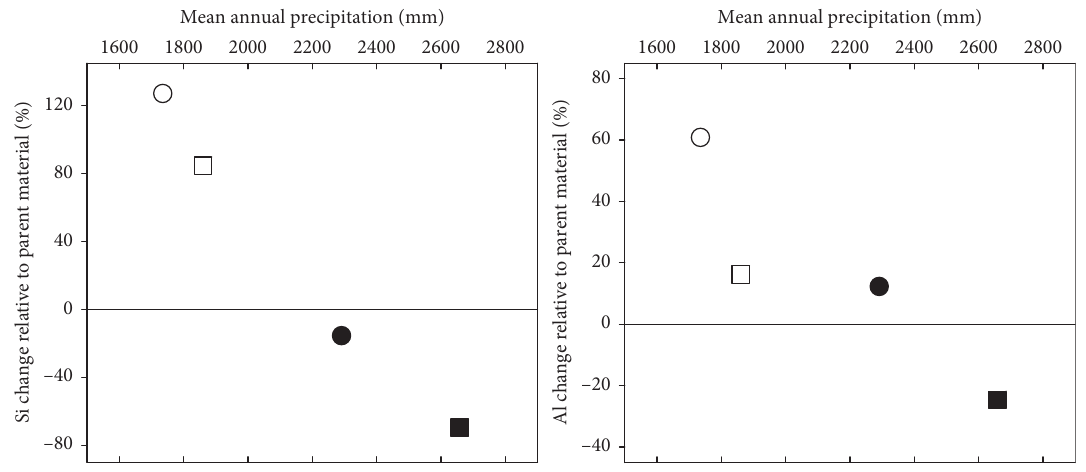
Figure 5: The percentage change of Si and Al in the soil series of Pyeongdae ( ■ ), Namwon ( ● ), Jeju ( □ ), and Gangjeong ( ○ ) from Jeju Island rainfall gradient as a function of mean annual rainfall. Each point was generated by depth integration to 1m of soil horizon